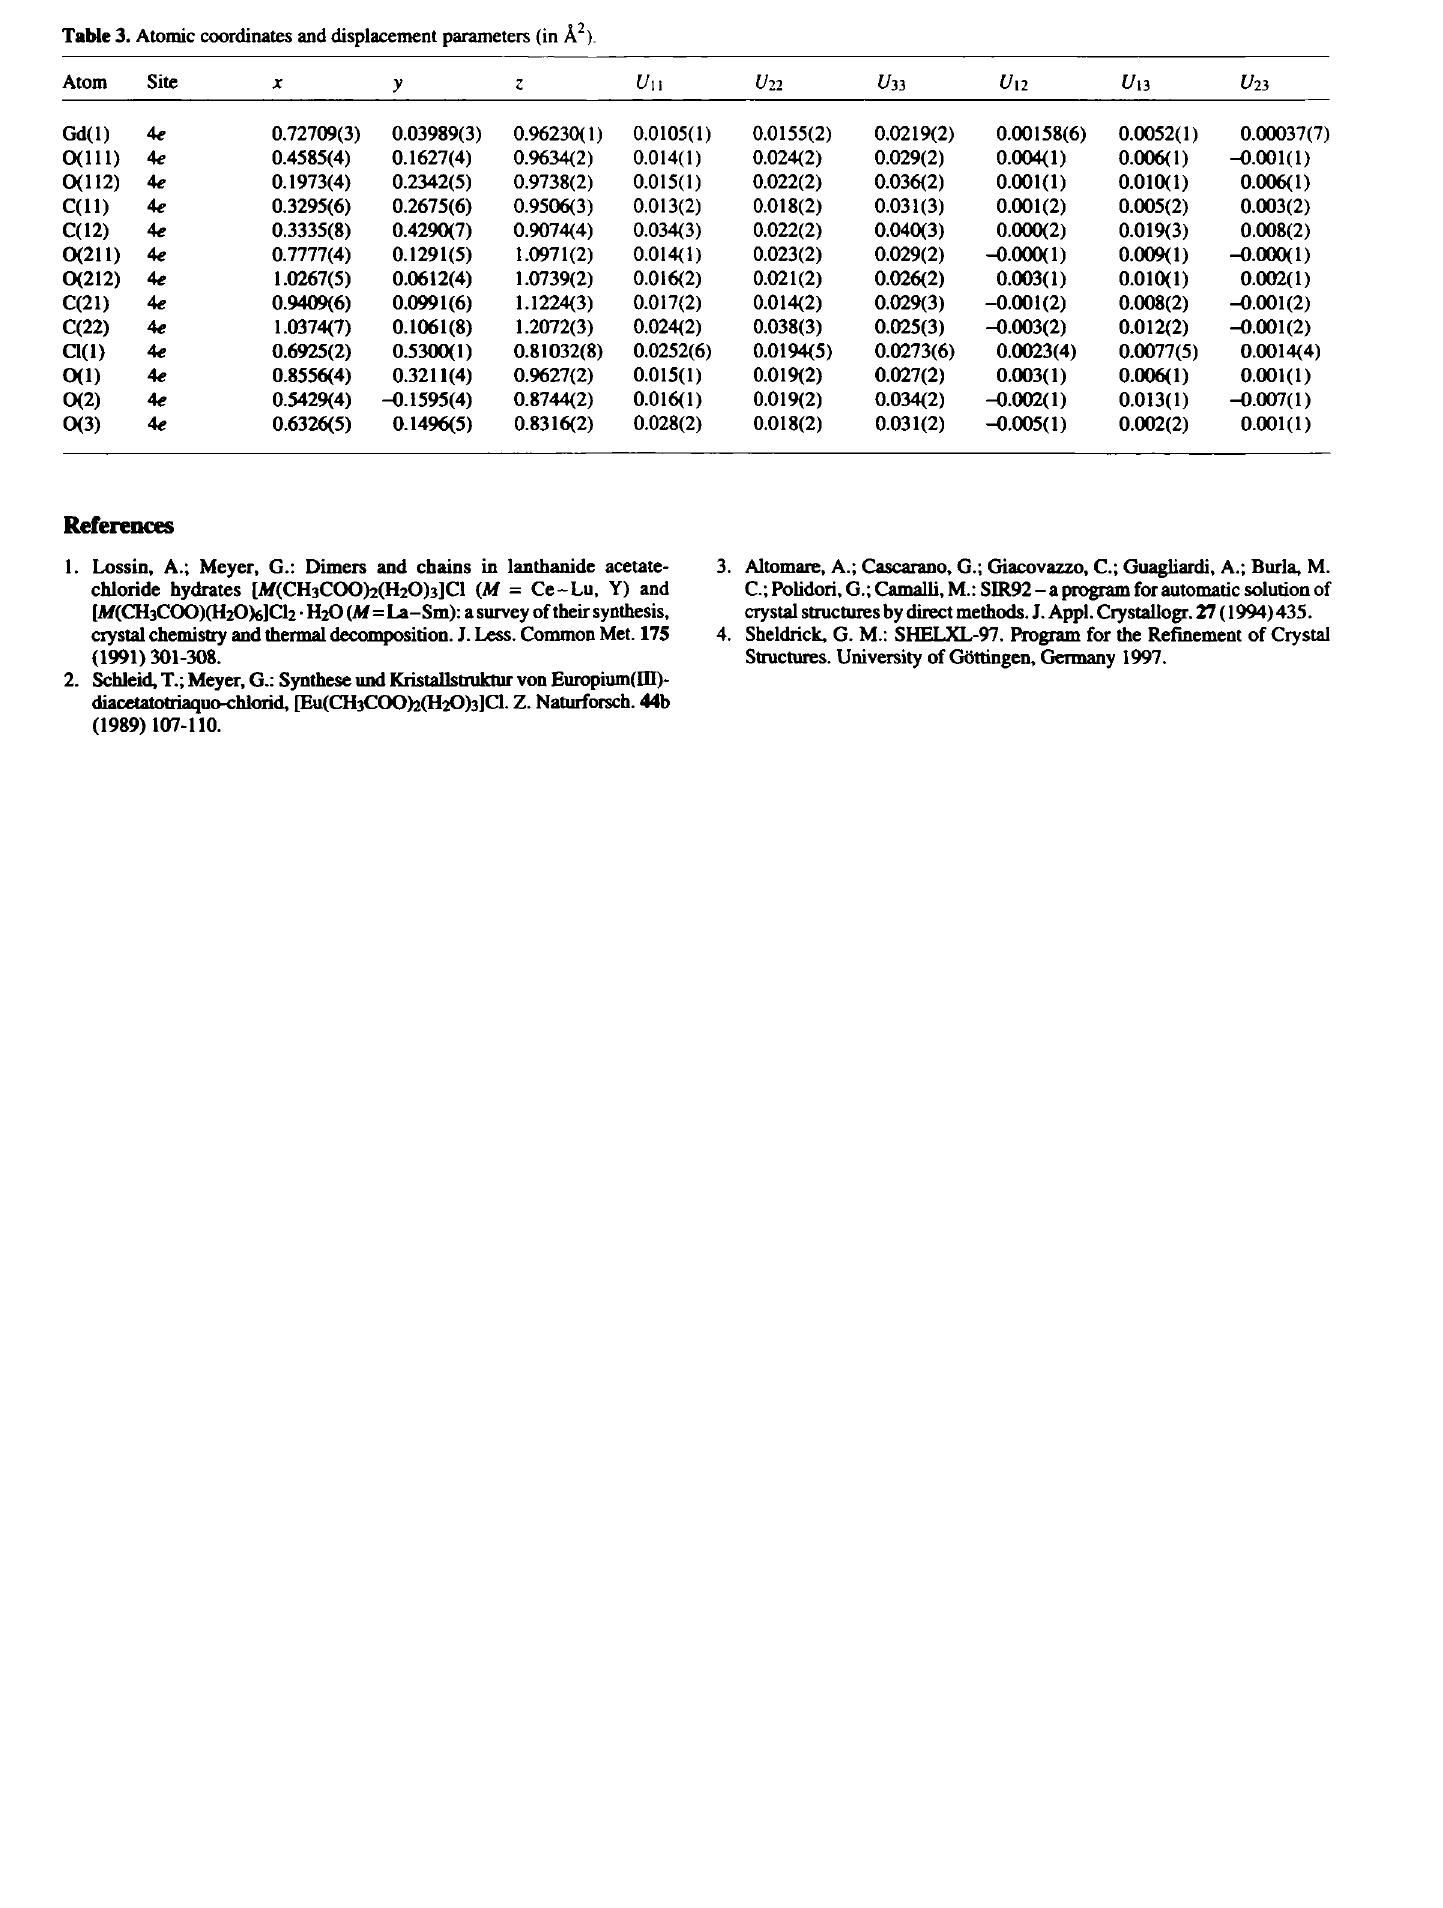
Table 3. Atomic coordinates and displacement parameters (in A 2